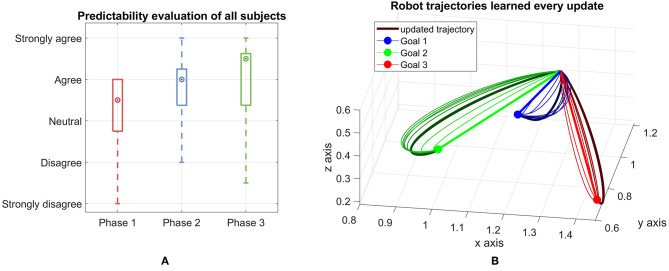
(A) Predictability evaluation from all subjects for each phase. The evaluation of participants for the first 4 updates, then the next 3 updates and the last 3 ones are shown in phase 1, phase 2 and phase 3, respectively. The mark shows the median of each group. The box contains 50% of the middle half of all given answers thus representing the interquartile range of the data. The whiskers mark the most extreme answers. (B) Robot trajectories learned for each goal every update. The first updates (straight lines) and last updates are marked thicker than the others.